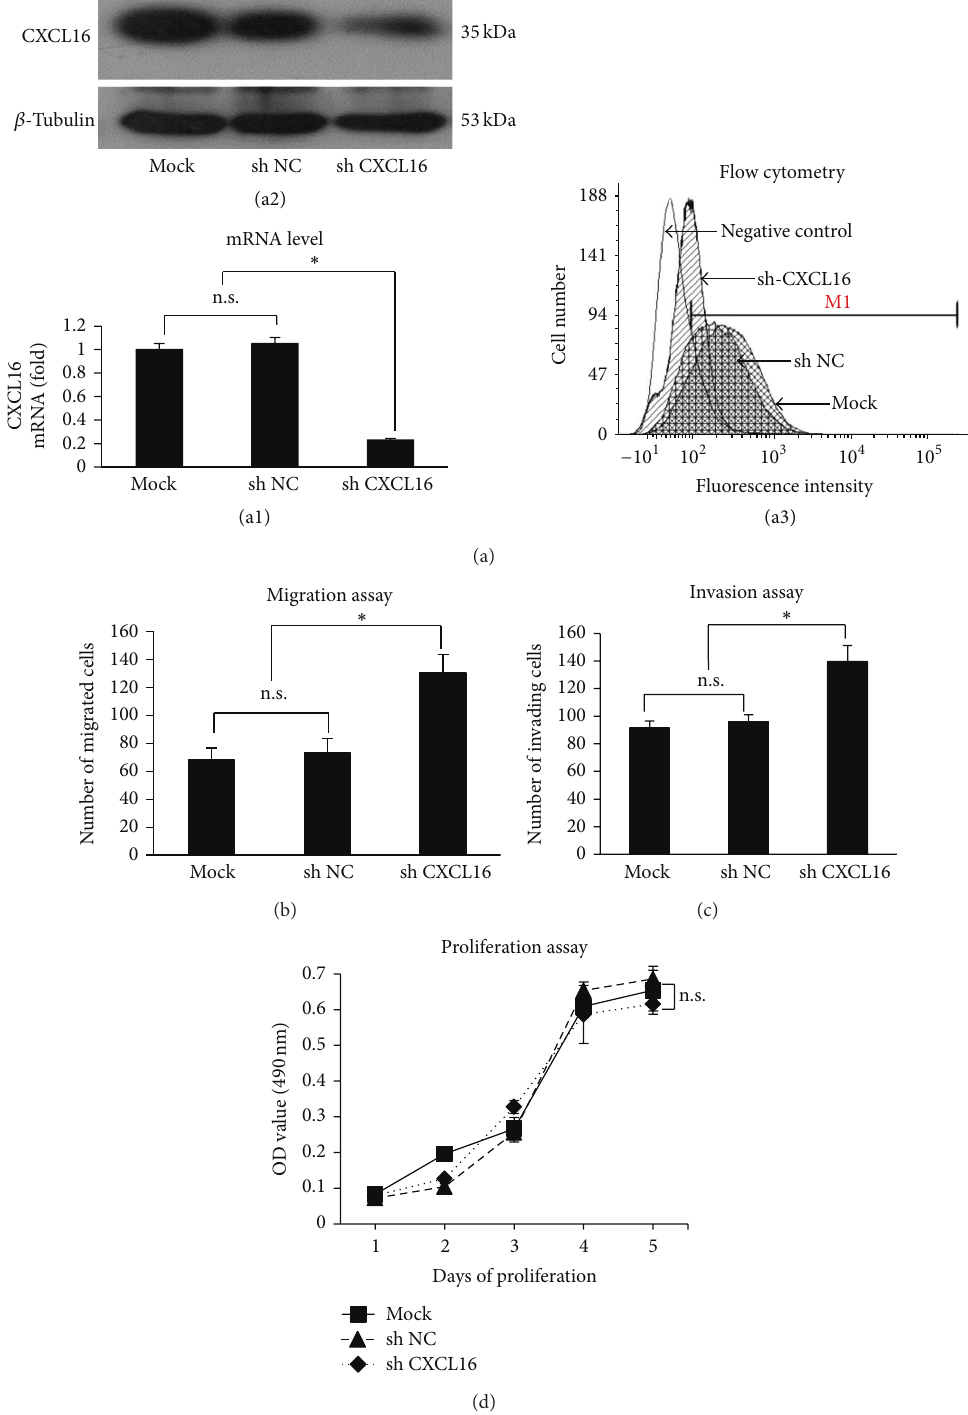
Figure 3: Knockdown of CXCL16 increases migration and invasion, but not proliferation, of MCF-7 cells. MCF-7 cells were treated with lipofectamine alone (mock) or infected with negative plasmids (sh NC) or CXCL16 targeted sequence (Sh CXCL16). 48 h later cells were collected and underwent migration, invasion, and proliferation assays. (a) ShRNA effectively inhibited expression of CXCL16 mRNA ((a1), qRT-PCR), total CXCL16 protein ((a2), western blotting), and TM-CXCL16 ((a3), flow cytometry). (b) CXCL16 knockdown enhanced migration of MCF-7 cells. ∗ 𝑃 < 0.01 compared with mock or negative control. n.s.: nonsignificant compared between mock and negative control. (c) CXCL16 knockdown enhanced invasion of MCF-7 cells. ∗ 𝑃 < 0.01 compared with mock or negative control. n.s.: nonsignificant compared between mock and negative control. (d) CXCL16 knockdown had no influence on proliferation of MCF-7 cells. n.s.: nonsignificant compared between mock and negative control (sh